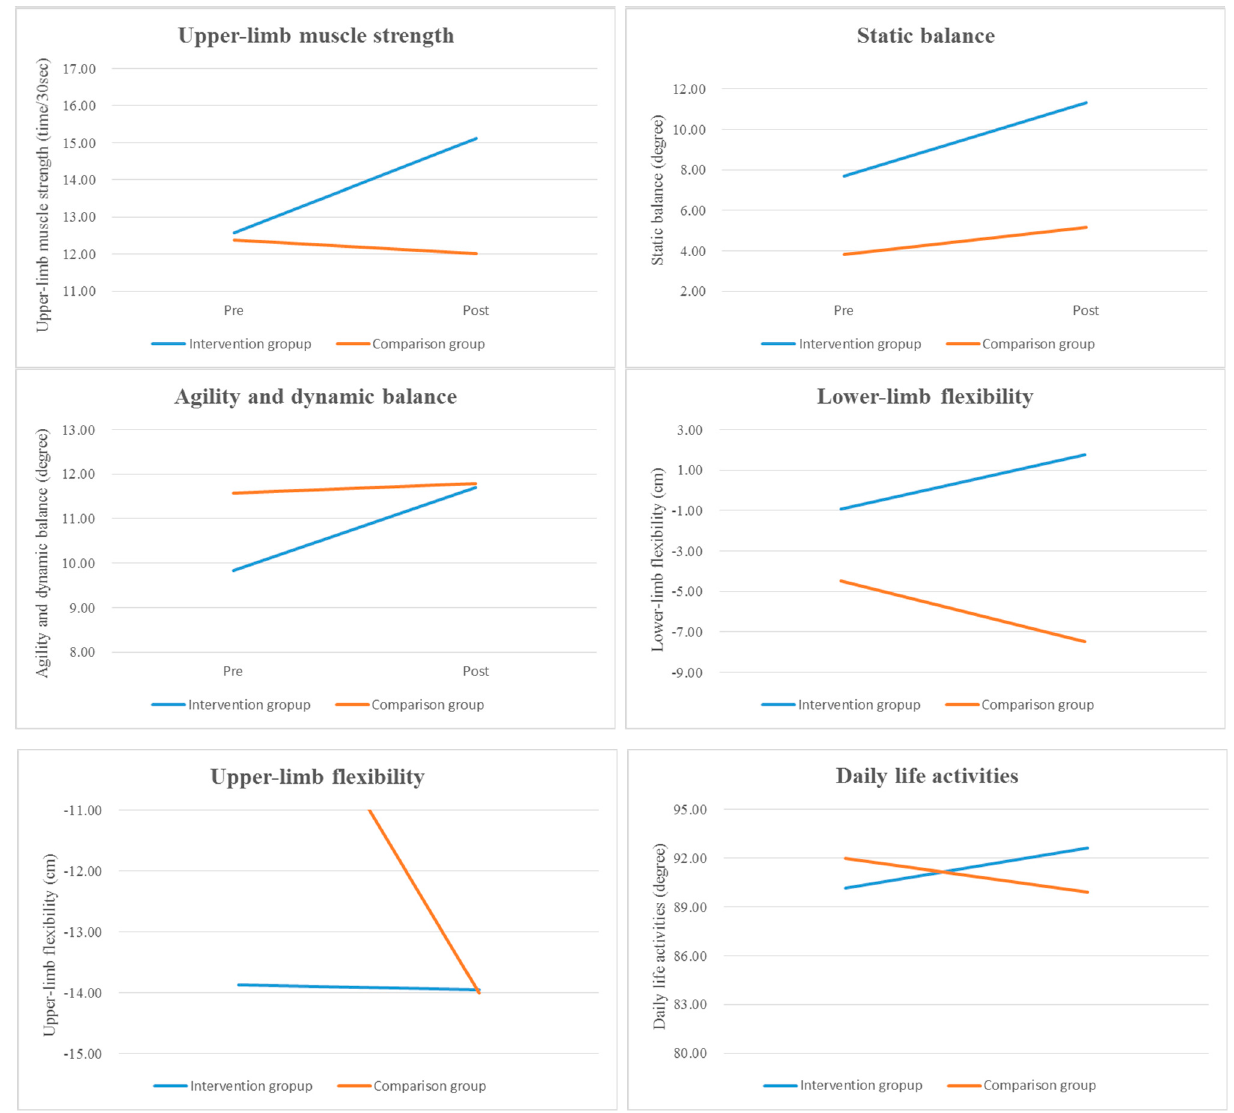
Figure 2. Time − dependent tendencies in functional fitness and daily life activities for the two groups. Note. Pre = pre ‐ test; Post = post ‐ test.